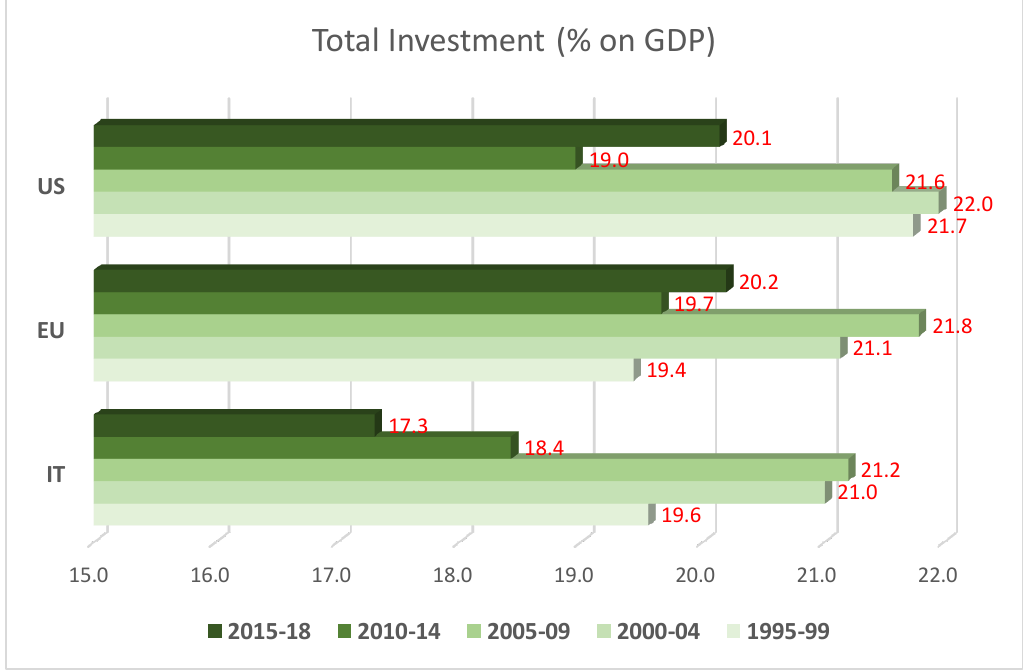
Figure 1: United States, European Union & Italy. Total Investment on GDP